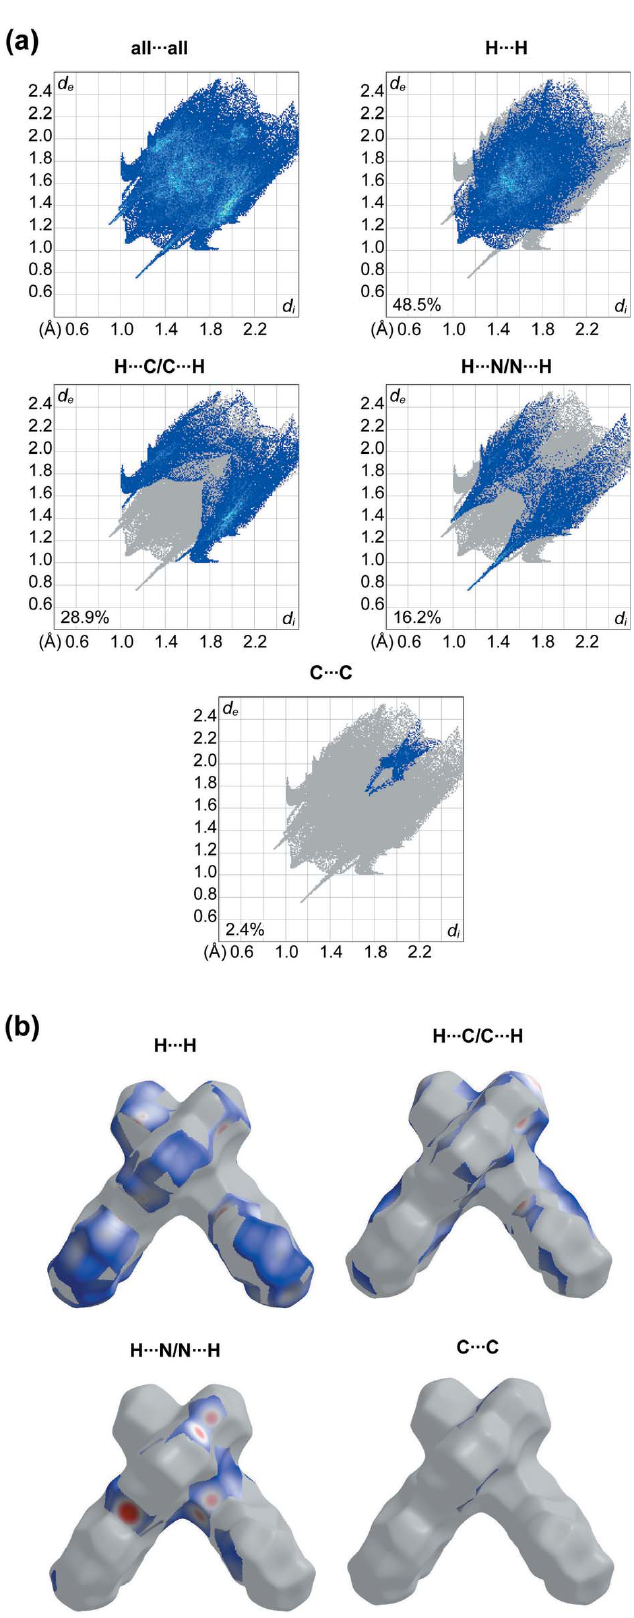
Figure 4 ( a ) The overall two-dimensional fingerprint plot and those decomposed into specified interactions. ( b ) Hirshfeld surface representations with the function d norm plotted onto the surface for the different interactions.